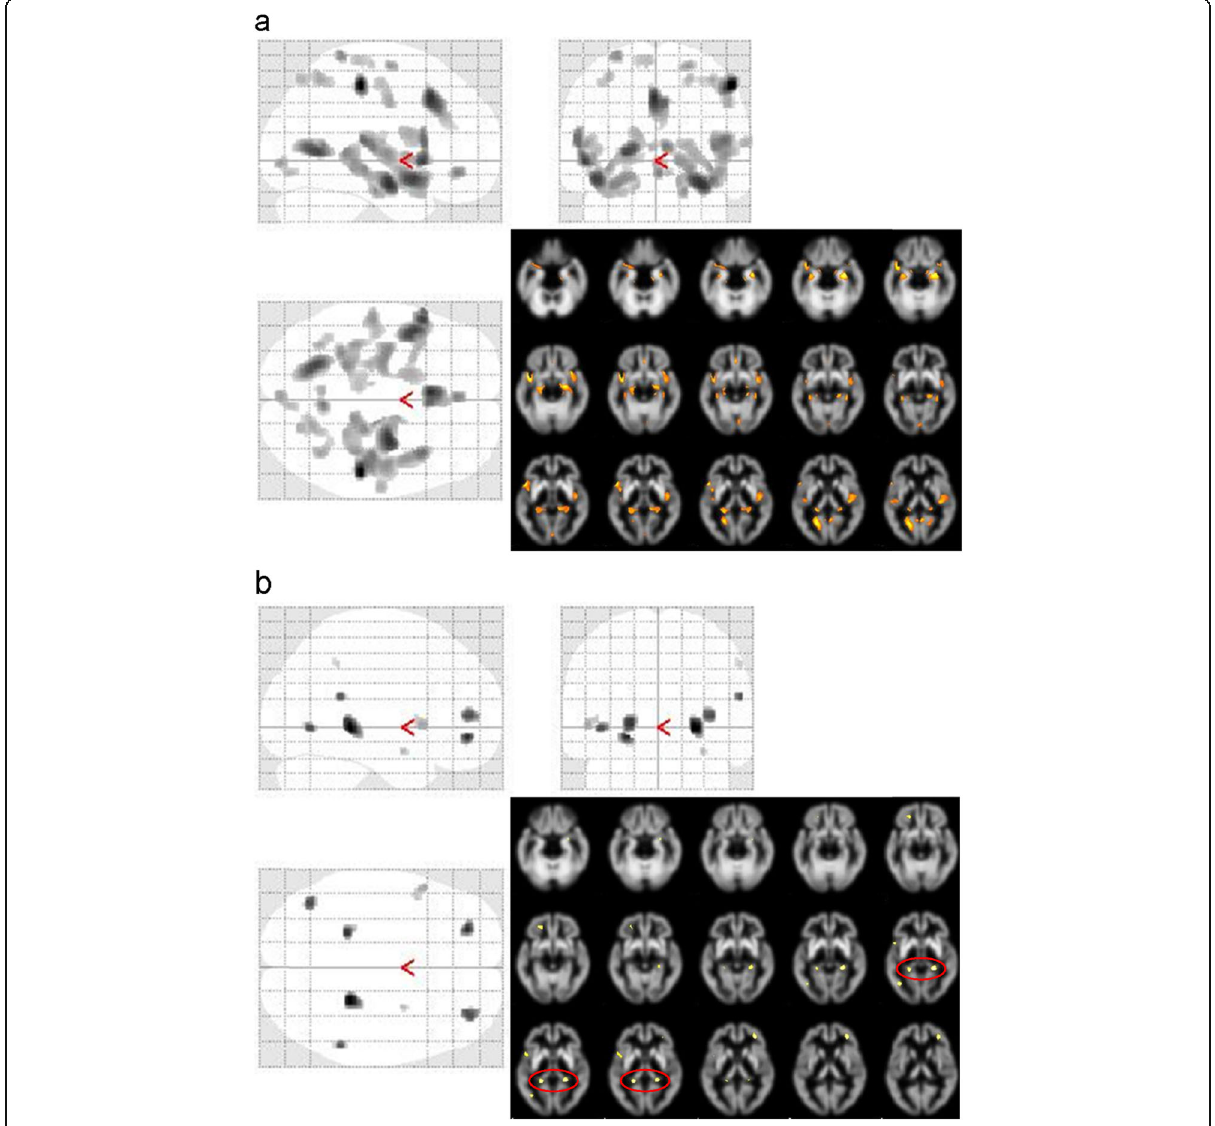
Fig. 5 VBM analysis for assessment of atrophic changes in AD patients. Comparison with preserved concentration showed many regional decreases in the AD group ( a ); however, if the differences of the whole brain size were corrected (preserved amount), only a few regions showed differences including the posterior part of the bilateral hippocampus (red circle, peak-level P < 0.001, cluster-level P uncorr < 0.05) ( b